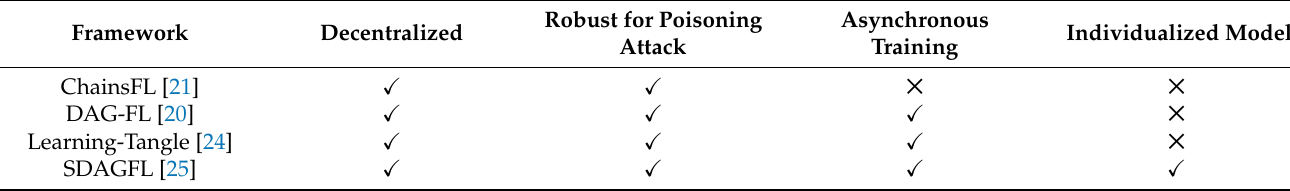
Table 1. Comparison of four Federated Learning Frameworks based on Tangle DAG-DLT.